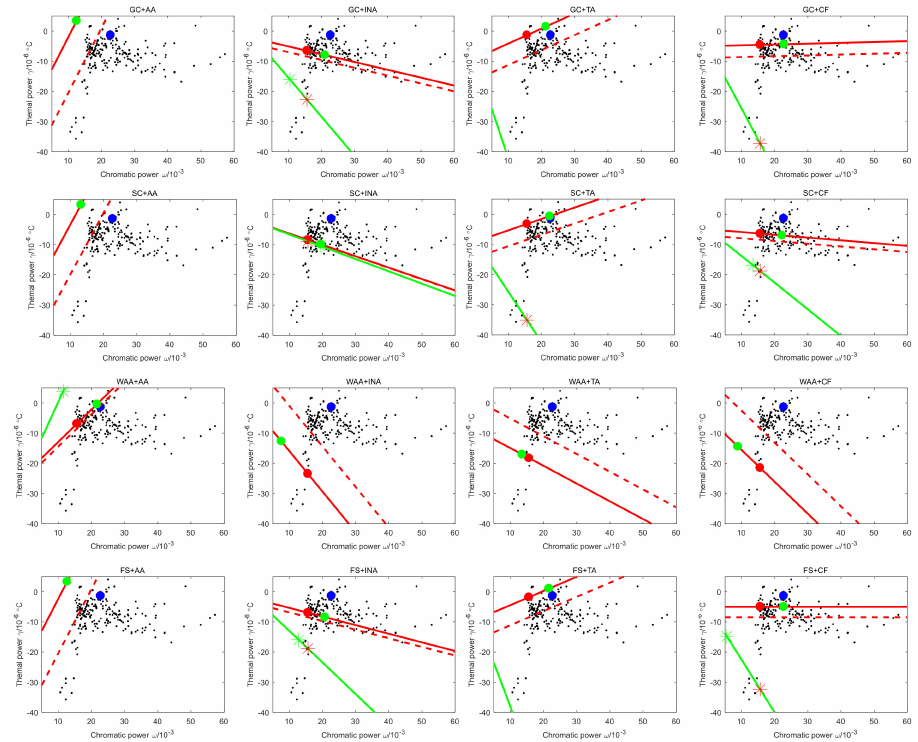
Figure 10. Athermal glass map of different material